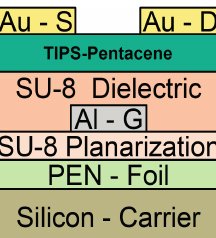
Figure 11. Schematic diagram of the OFET stack used for testing the ideal solvent mixture from experimental part IV for the micro - dispensed TIPS-pentacene based transistors.